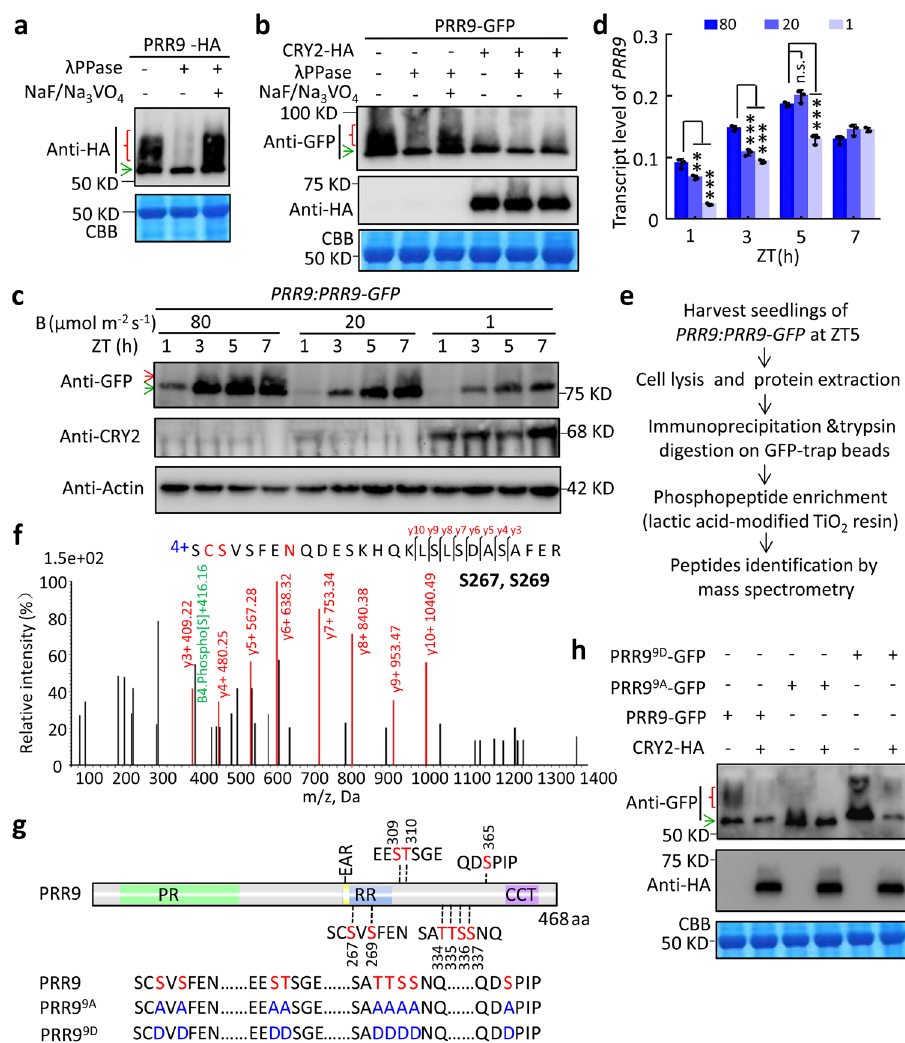
Fig. 3 | CRY2 inhibits phosphorylation of PRR9 in a light intensity-dependent manner. a Immunoblot showing the band shift of PRR9-HA was eliminated upon λ PPasetreatment.TotalPRR9-HAtobaccoproteinlysatesweretreatedwith λ PPase or phosphatase inhibitors NaF and Na 3 VO 4 , as noted. Red open brace and green arrow indicated phosphorylated and unphosphorylated forms of PRR9, respec- tively. CBB staining was used as a loading control. b Band shift of PRR9-GFP was largely reduced when co-expressing with CRY2-HA. Total tobacco protein lysates weretreatedasin a . c ImmunoblotshowingdynamicphosphorylationofPRR9was regulated by blue light intensity. Ten days PRR9:PRR9-GFP transgenic plants were exposed to 80, 20 or 1 μ molm − 2 s − 1 blue light and harvested at indicated time points. Lysates were analyzed by immunoblot with GFP,CRY2, and Actin antibody. Red and green arrows indicated phosphorylated and unphosphorylated form of PRR9, respectively. d Transcriptional expression level of PRR9 of seedlings in c by RT-qPCR.Dataweremean±s.d., n =3,technicalrepeats.** p <0.01,*** p